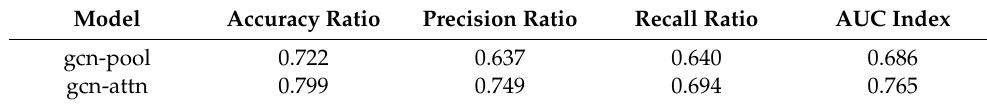
Table 4. Average results of four evaluation metrics based on the AIDS dataset.